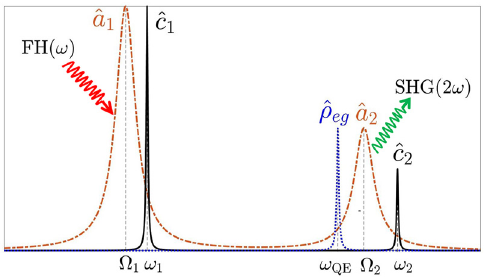
Figure 3: Resonances of the plasmonic ( ̂ a ) and cavity ( ̂ c ) modes are 1 , 2 1 , 2 and 𝜔 , respectively. SHG conversion is carried out depicted by Ω 1 , 2 1 , 2 due to strong localization [51]. Both first over the plasmon modes ̂ a 1 , 2 harmonic (FH) and second harmonic (SH) fields are localized in plasmon ) is chosen around the modes. The resonance of the QE (depicted by 𝜌 eg ̂ a plasmon mode —couples to it. The conversion (enhancement) 2 dynamics is given in the text in